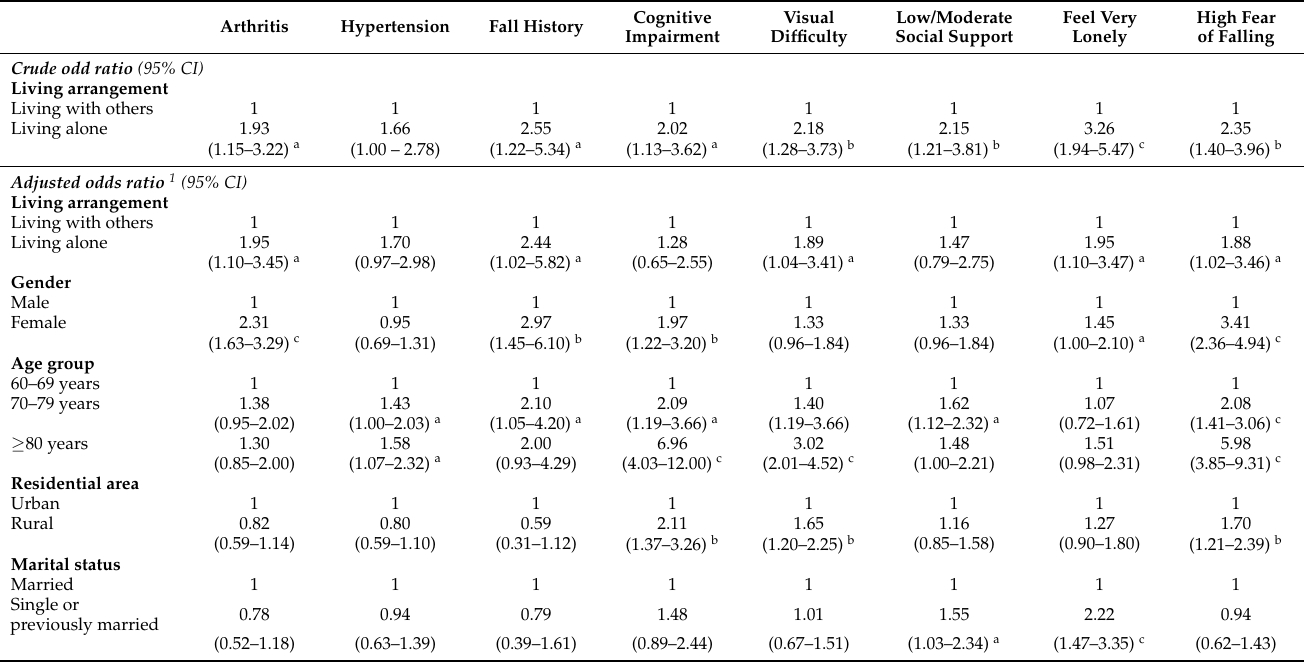
Table 2. Association between living arrangement and self-reported health outcomes ( n =